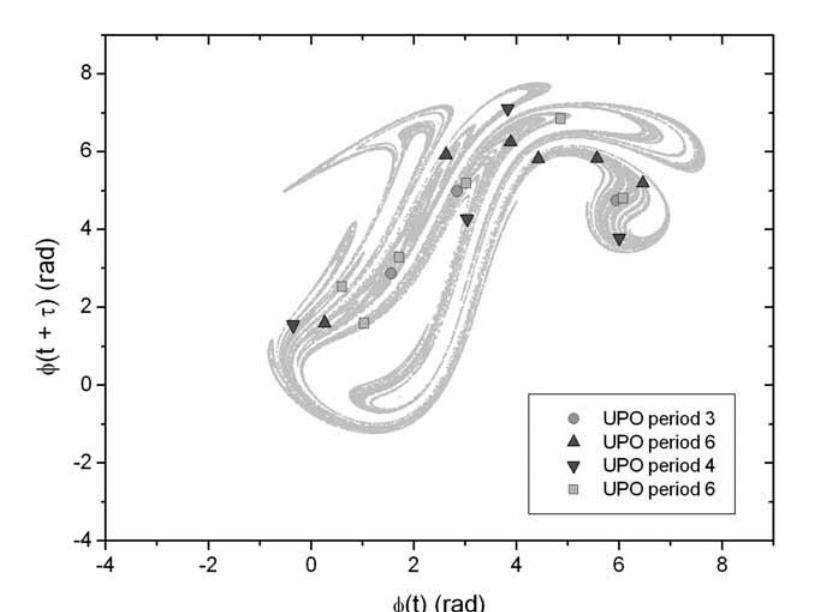
Fig. 5. Reconstructed strange attractor.